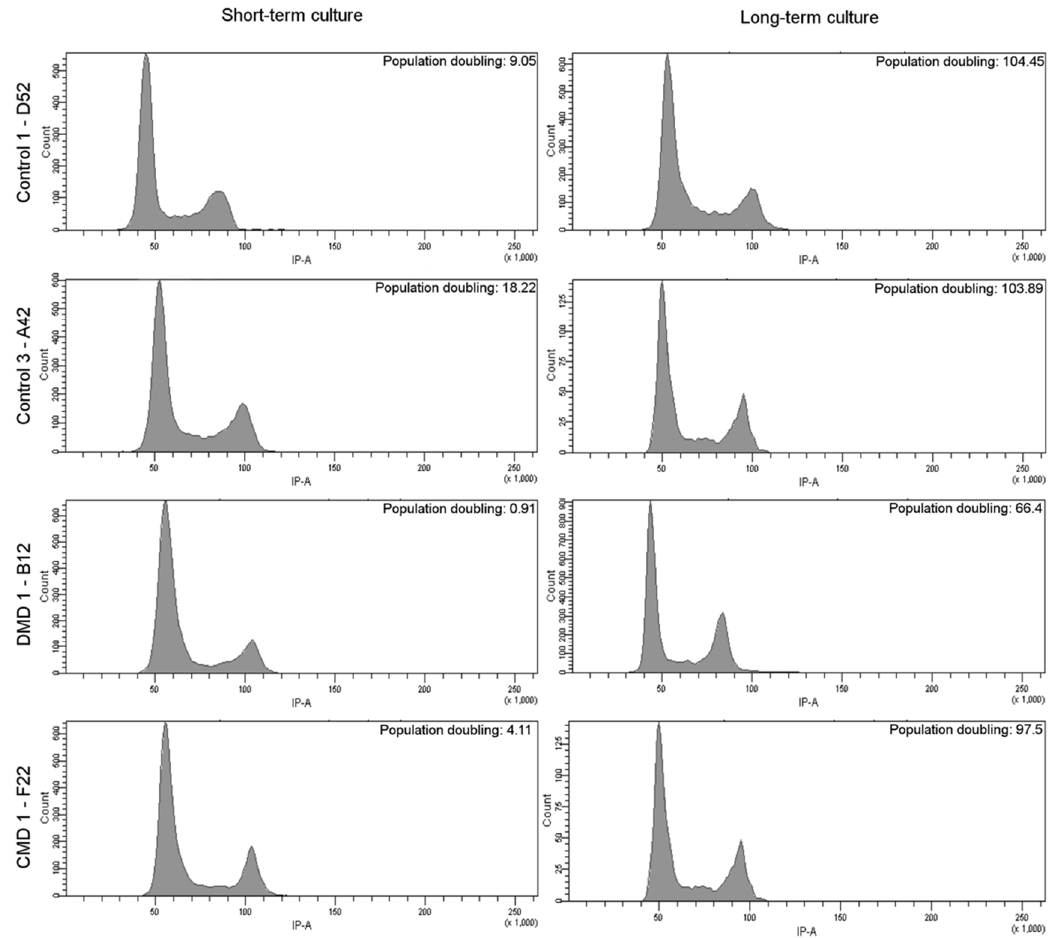
Figure 5. Cell cycle analysis of short-term and long-term cultured iHMuSC clones. Four randomly chosen clones were tested for cell cycle analysis at short- (left panel) and long- (right panel) term culture. Flow cytometer analysis of propidium iodide staining is shown, reflecting the amount of DNA in the cells.